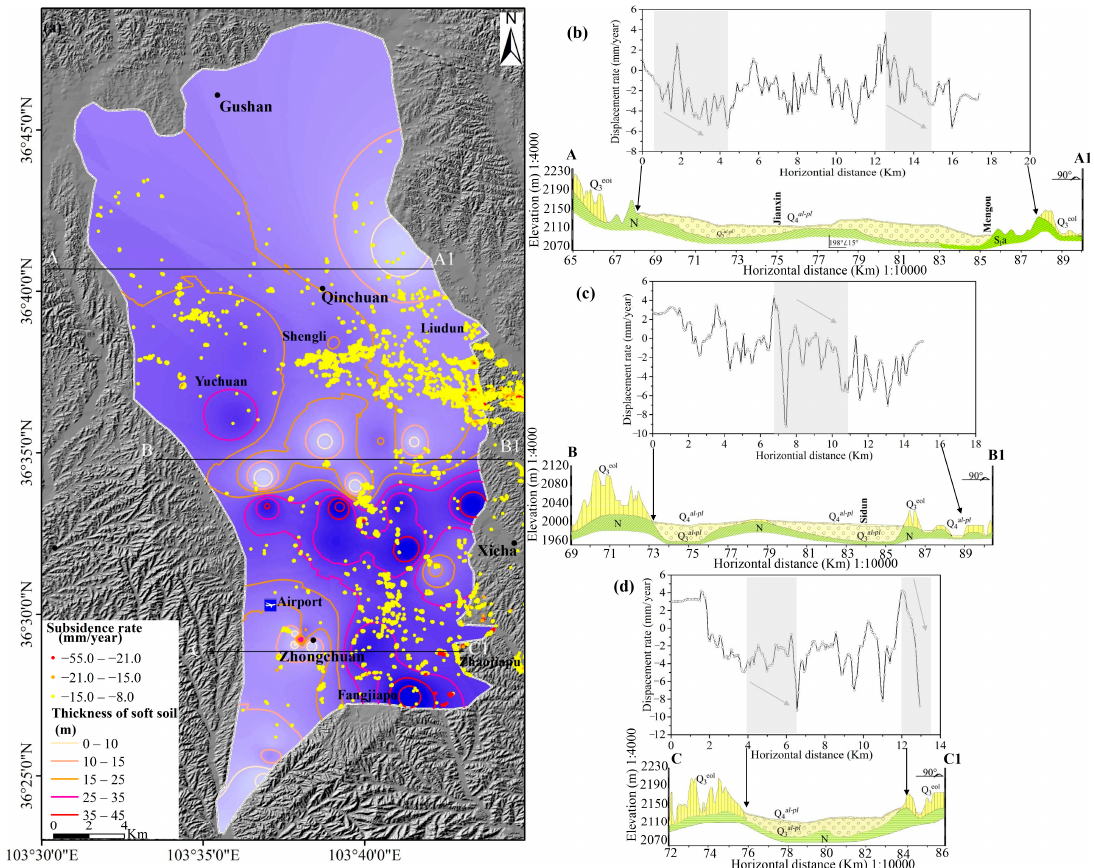
Figure 12. Relationship between the thickness of compressible deposits with subsidence in LZND: ( a ) isoclines of compressible deposits thickness and average subsidence rate between 2015 and 2016; ( b ) geological cross section and subsidence rate profile of A-A1; ( c ) geological cross section and subsidence rate profile of B-B1; and ( d ) geological cross section and subsidence rate profile of C-C1. Light grey rectangles in ( b – d ) indicate that the subsidence rate increased with the increasing thickness of compressible deposits.